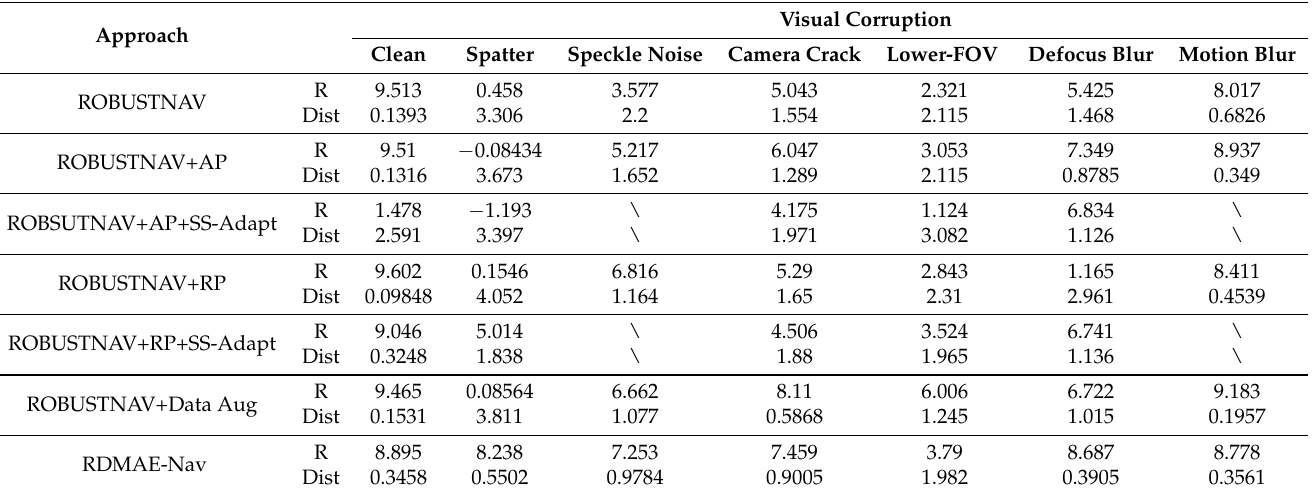
Table 2. Agent behavior analysis of the proposed RDMAE-Nav by comparing R and Dist metric. In general, if the agent obtains a higher R and a lower Dist, the agent achieves more reasonable